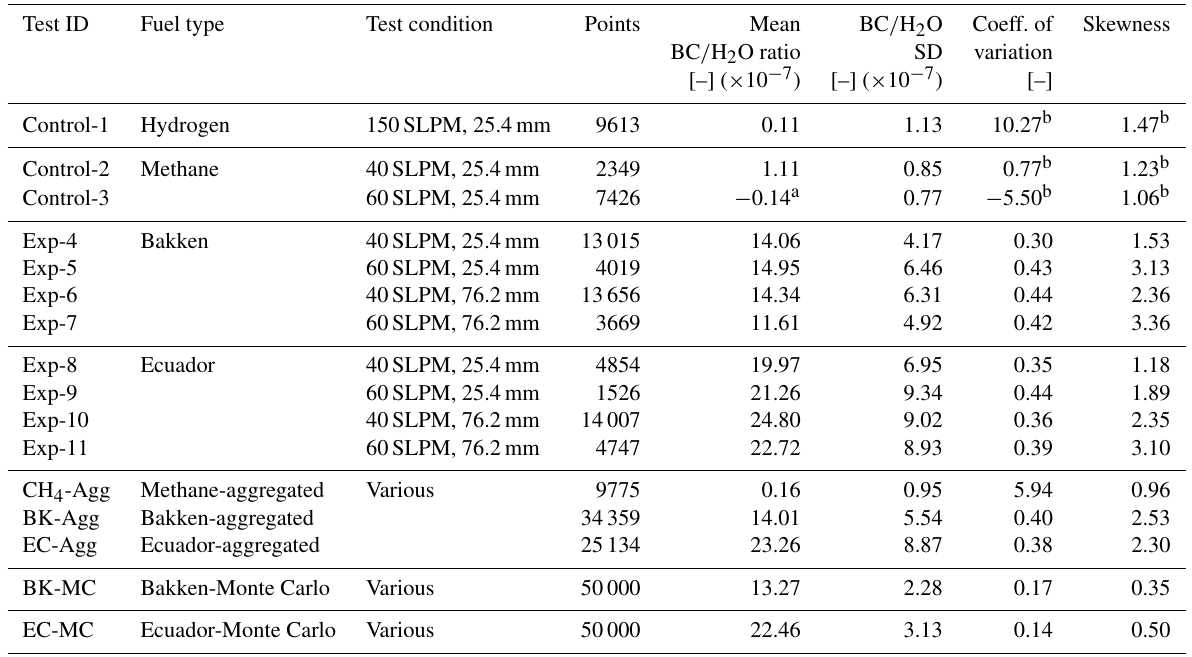
Figure 5. H 2 O absorption peaks in isolated, spectrally resolved form compared to the column distribution result from the Nelder–Mead optimization search. Table 2. Summary of flare test black carbon / H 2 O ratio results and relevant